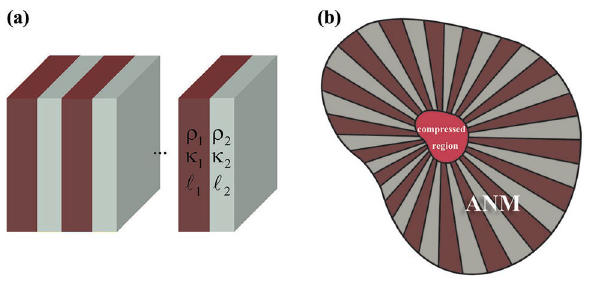
Figure 5. ( a ) A multi-layered system which mimics an anisotropic slab behavior. ( b ) The schematic of the final configuration of the realized structure.